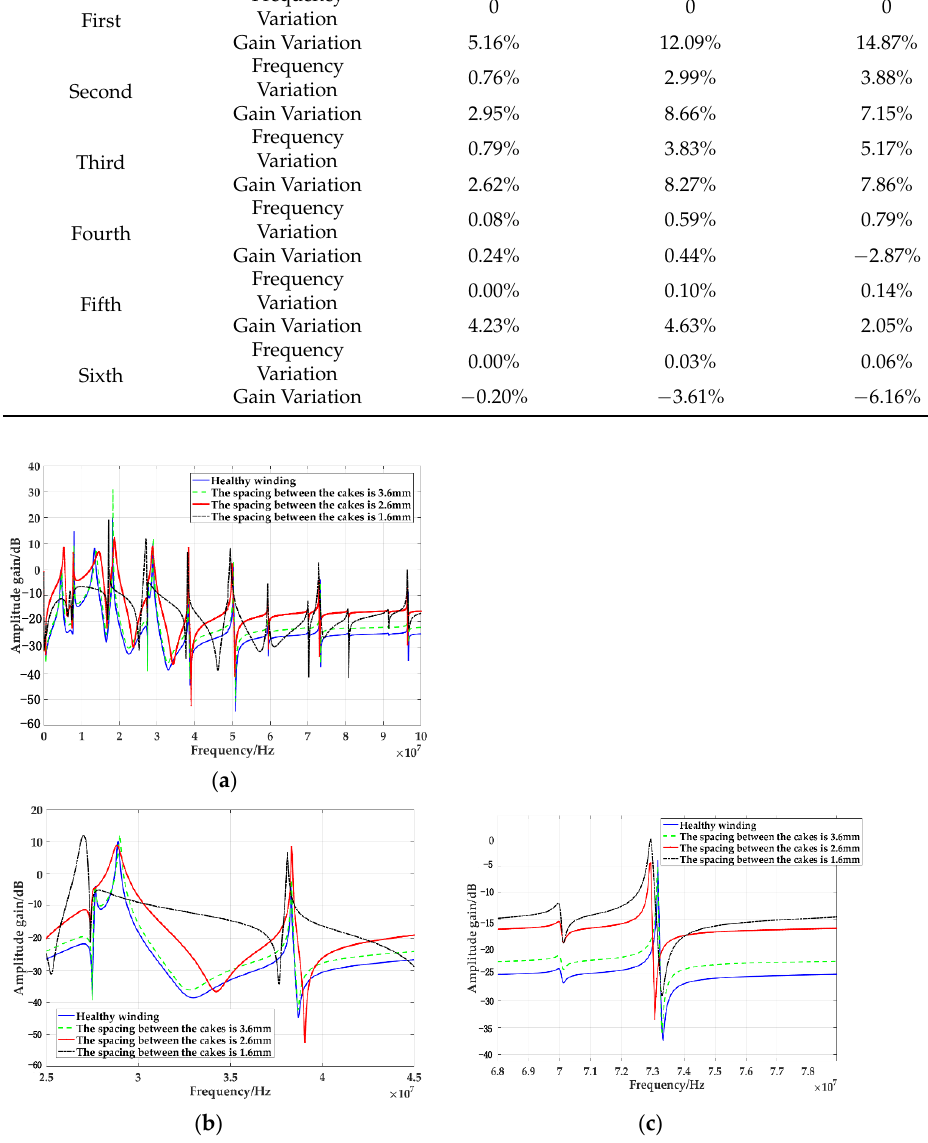
Figure 14. Frequency response curve of winding axial deformation: ( a ) full-band frequency response curve, ( b ) low-frequency partial amplification frequency response curve, and ( c ) high-frequency partial amplification frequency response curve.